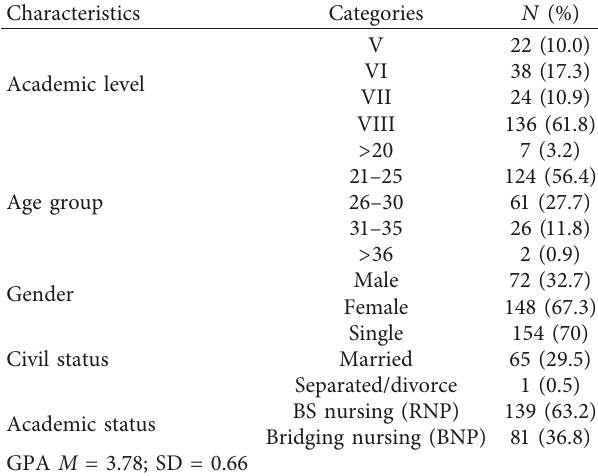
Table 1: Profile of the